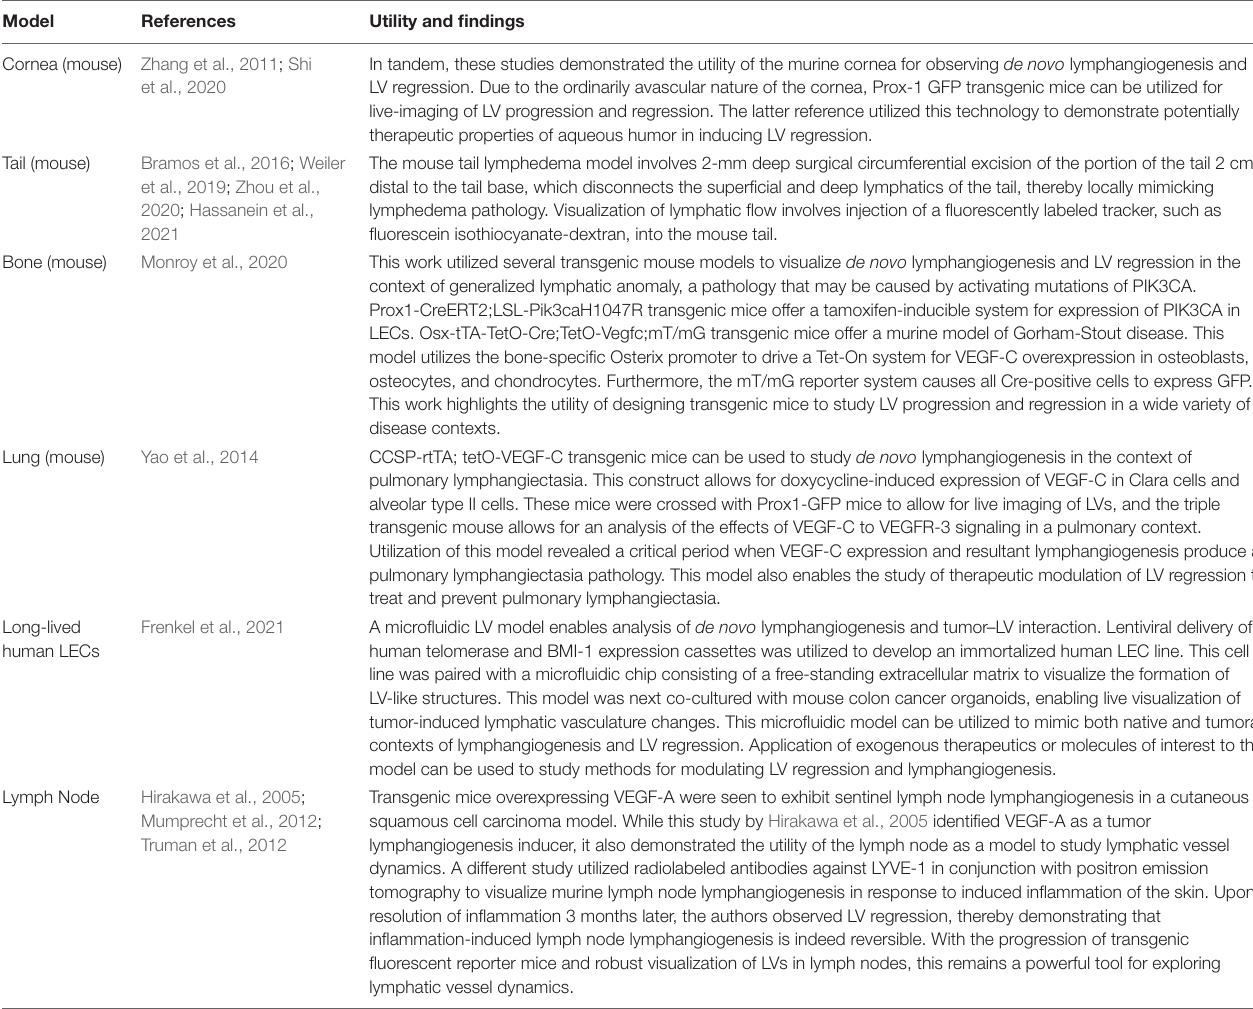
TABLE 3 | Animal models for the study of LV regression.